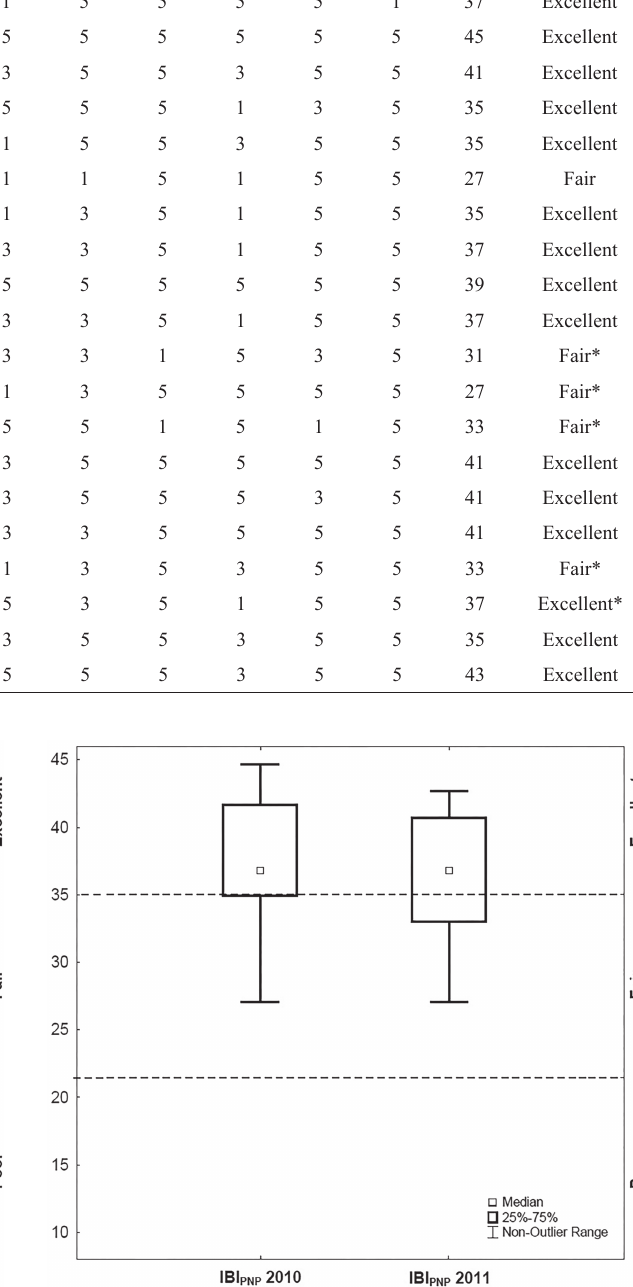
for the years of 2010 and PNP